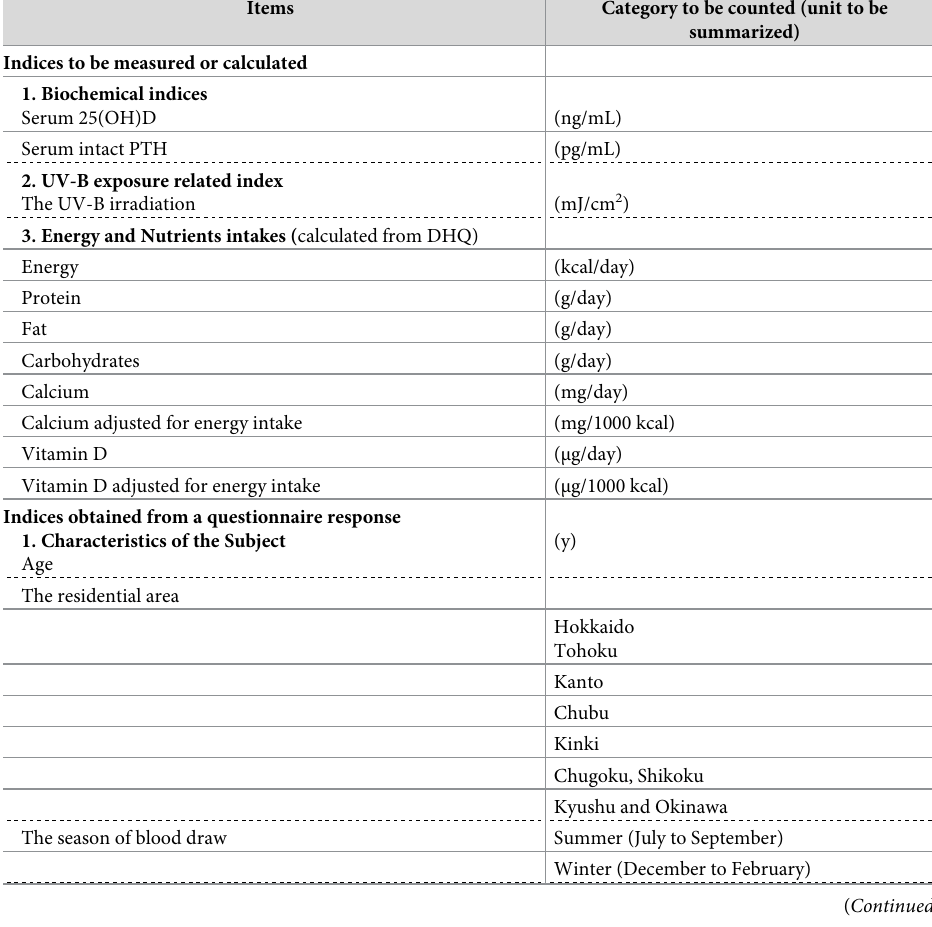
Table 1. Demographic characteristics and questionnaire